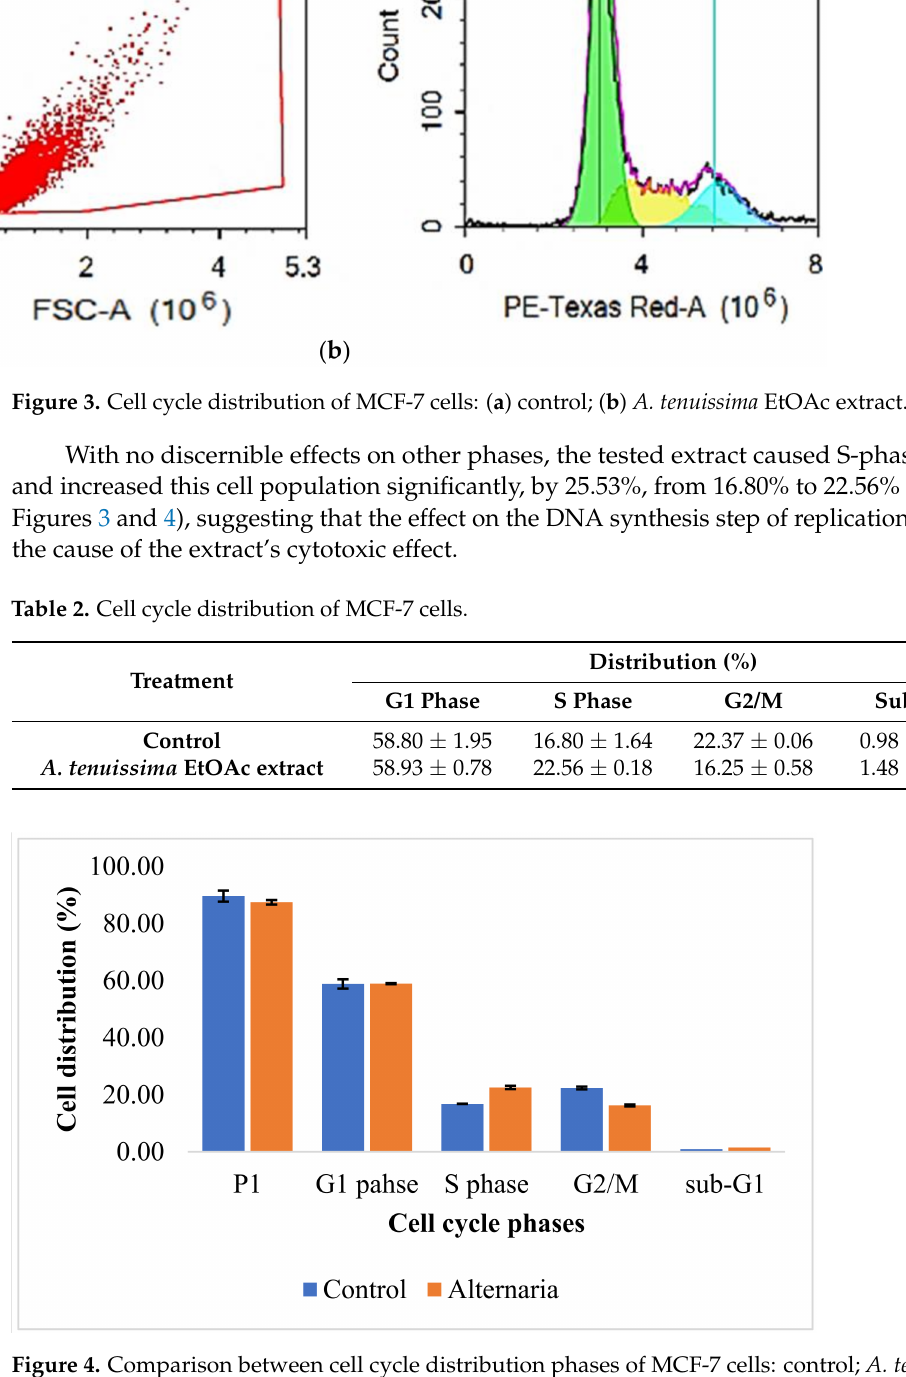
Figure 4. Comparison between cell cycle distribution phases of MCF-7 cells: control; A. tenuissima EtOAc